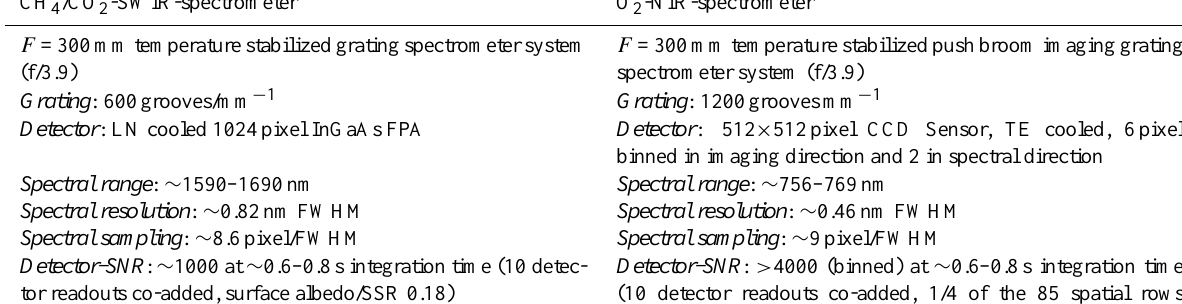
Table 1. MAMAP sensor parameters. CH 4 /CO 2 -SWIR-spectrometer O 2